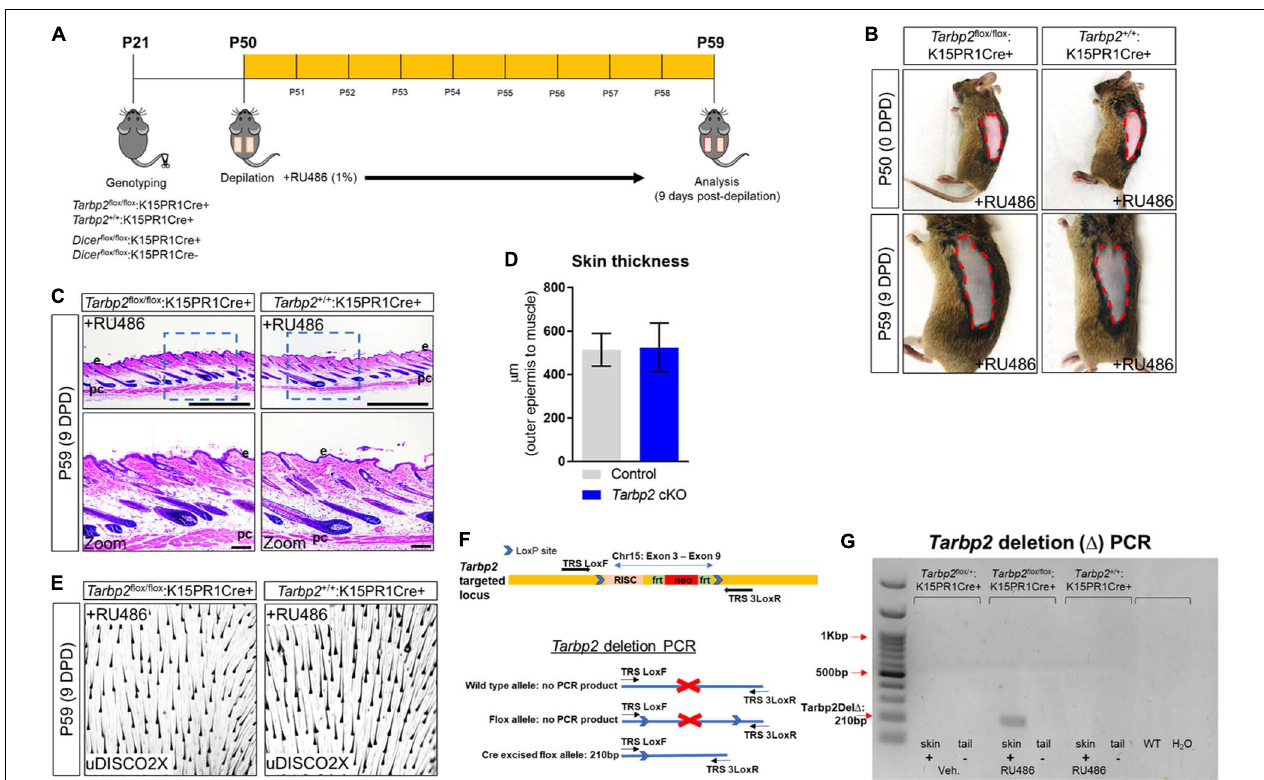
FIGURE 1 | Conditional knock out of Tarbp2 with hair follicle bulge stem cells. (A) Schema outlining the genotyping and conditional knockout of Tarbp2 and Dicer within bulge stem cells. (B) Images of the depilated regions of control ( Tarbp2 + / + ;K15PR1Cre+) and experimental ( Tarbp2 flox / flox ;K15PR1Cre+) mice at 0 days post depilation (DPD) and 9 DPD. (C) Histological analysis of 9 DPD skins in both control ( Tarbp2 + / + ;K15PR1Cre+) and experimental ( Tarbp2 flox / flox ;K15PR1Cre+) mice. Boxed region is magnified in the lower panels. Thickness measured from the panniculus carnosus (pc; muscle) to the outer epidermal layer (e). Bars (top panels = 1 mm; bottom panels = 100 um) (D) Skin thickness. Distance from the striated muscle layer to the outer epidermal layer ( µ m). (E) Whole mount uDISCO analysis of 9DPD skins in both control ( Tarbp2 + / + ;K15PR1Cre+) and experimental ( Tarbp2 flox / flox ;K15PR1Cre+) mice. (F) Schema of the targeting construct for generation of Tarbp2 floxed mice (top panel). Schema of the PCR strategy to determine Tabp2 ablation efficiency within tissue samples (bottom panel). (G) Tarbp2 deletion PCR results using RU486 pre- and post-treated tissue